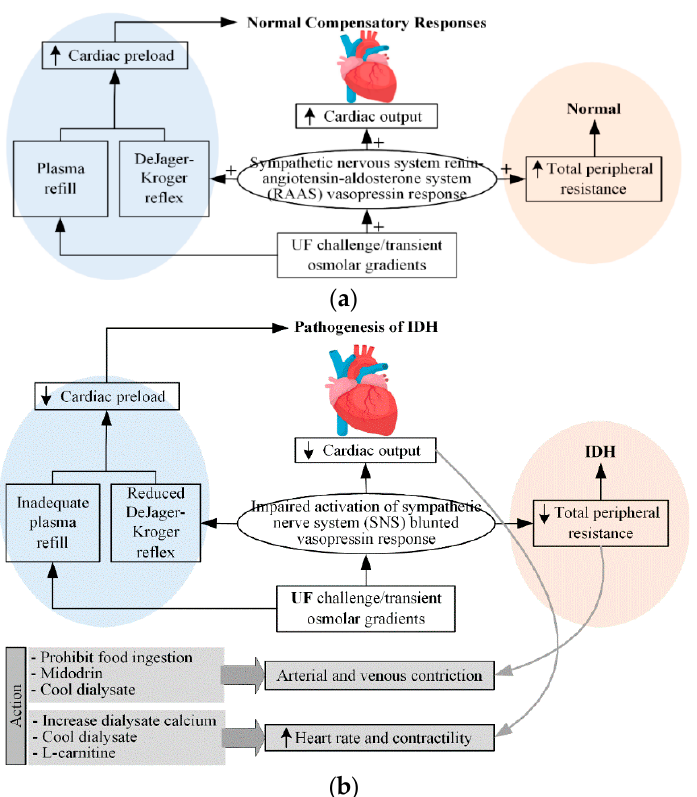
Figure 1. ( a ) normal and ( b ) inadequate compensatory responses to maintain BP during dialysis ([14]). (In Figure 1a, + denotes the response sensitivity.)